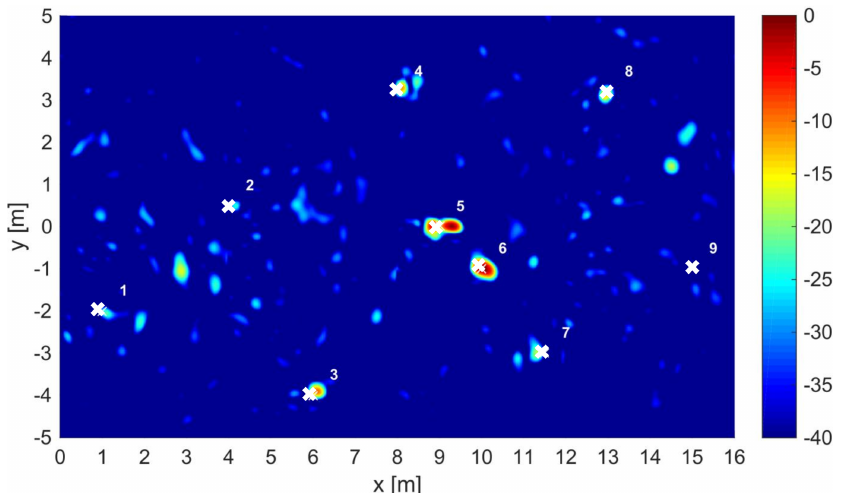
Figure 8. MF based image of Figure 4 after application of the ACF-based enhancement procedure. The target position and type are indicated with a white cross and number.